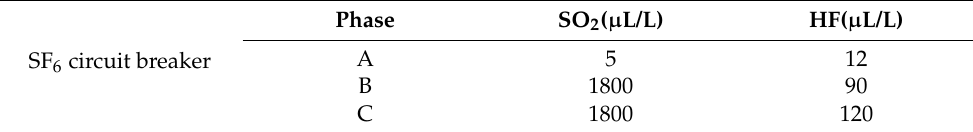
Table 5. Composition of SF 6 gas in the circuit breaker during comparative tests.